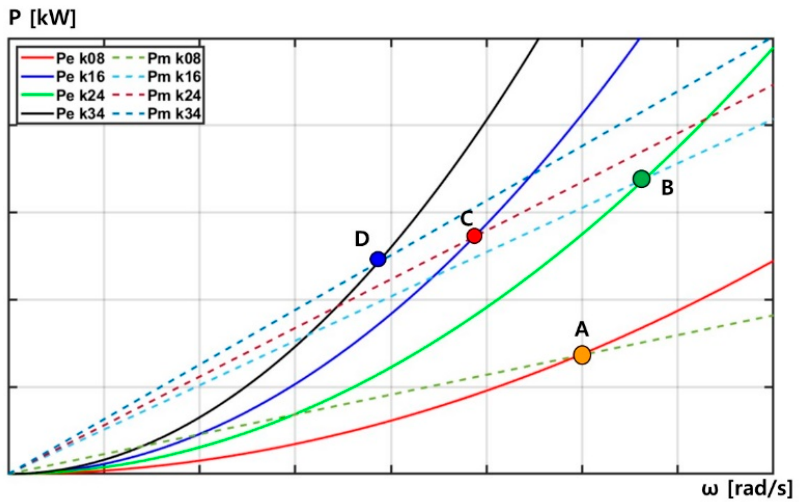
Figure 23. Comparison of output power generation performance according to torque coefficient of optimal torque control algorithm (legends indicate torque coefficients).